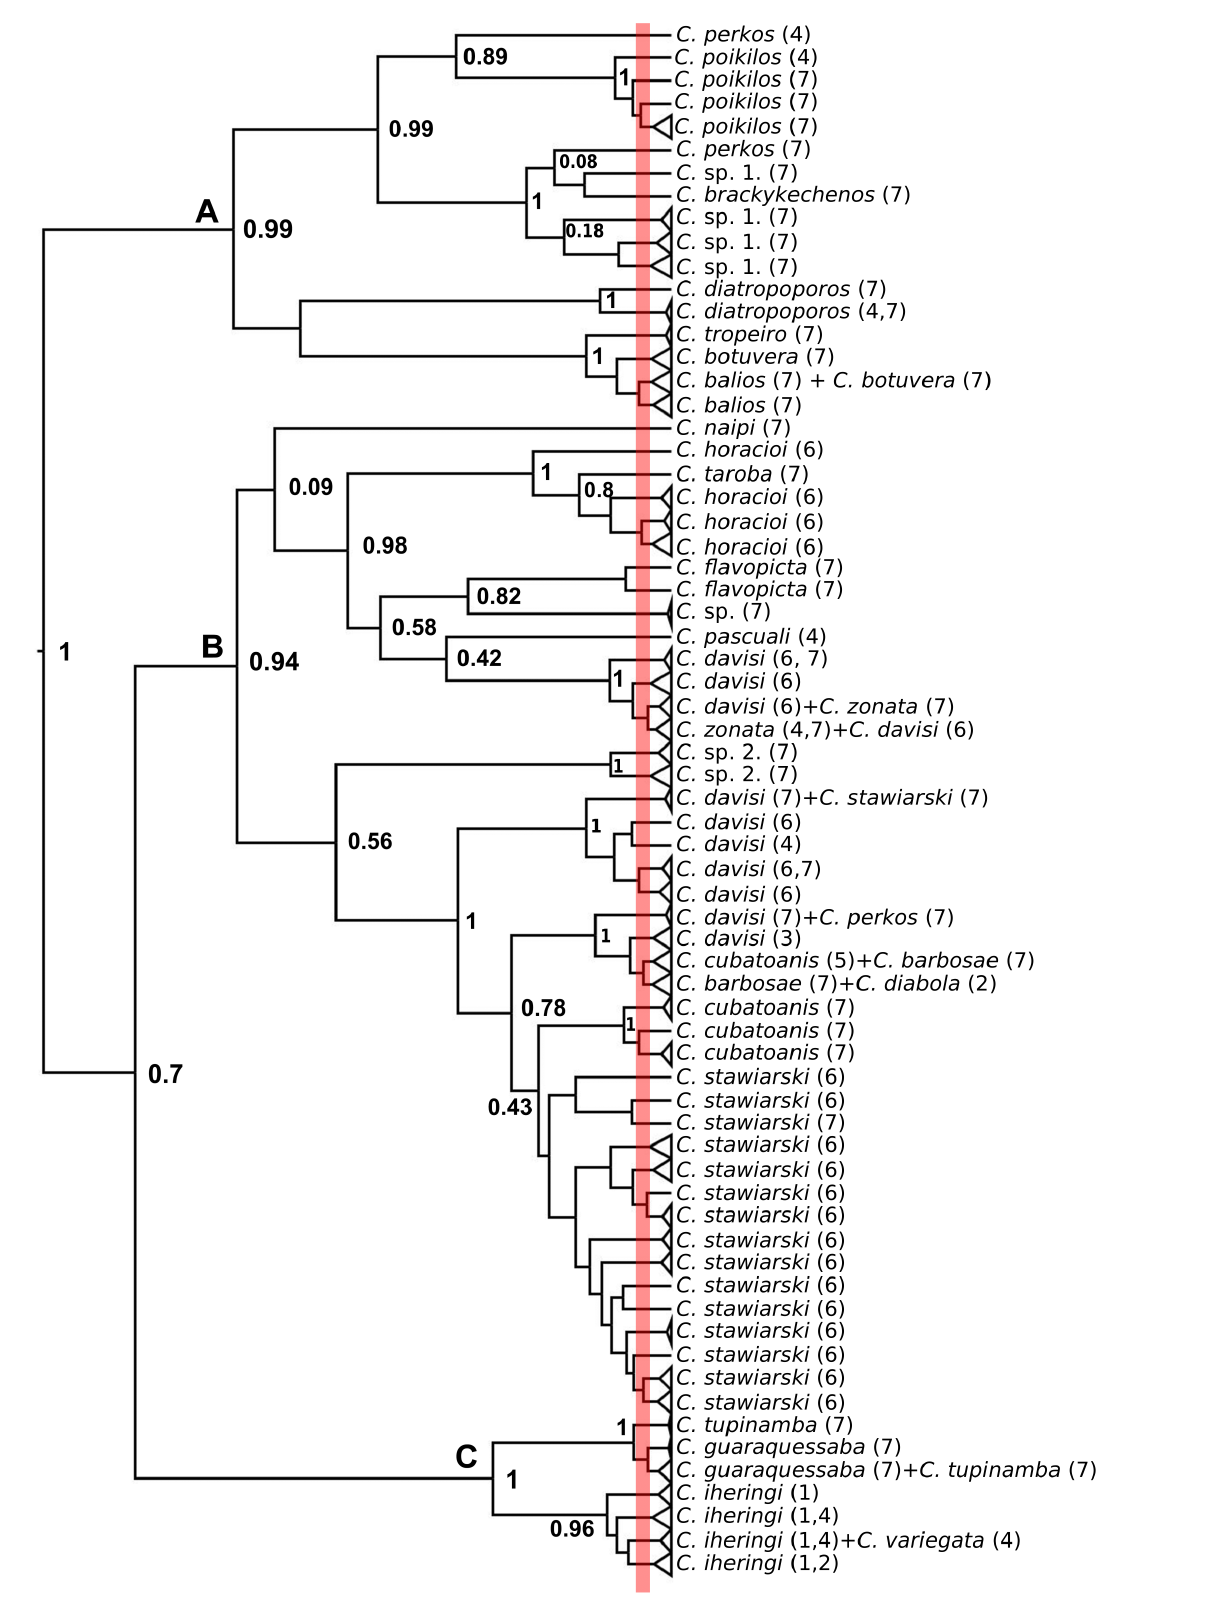
FIGURE 11 | Bayesian phylogenetic tree of Cambeva species obtained from COI data. The vertical red line shows the coalescent branching process estimated by using the single-threshold model in the GMYC combination 4 (strict clock model vs . a coalescent constant population size tree